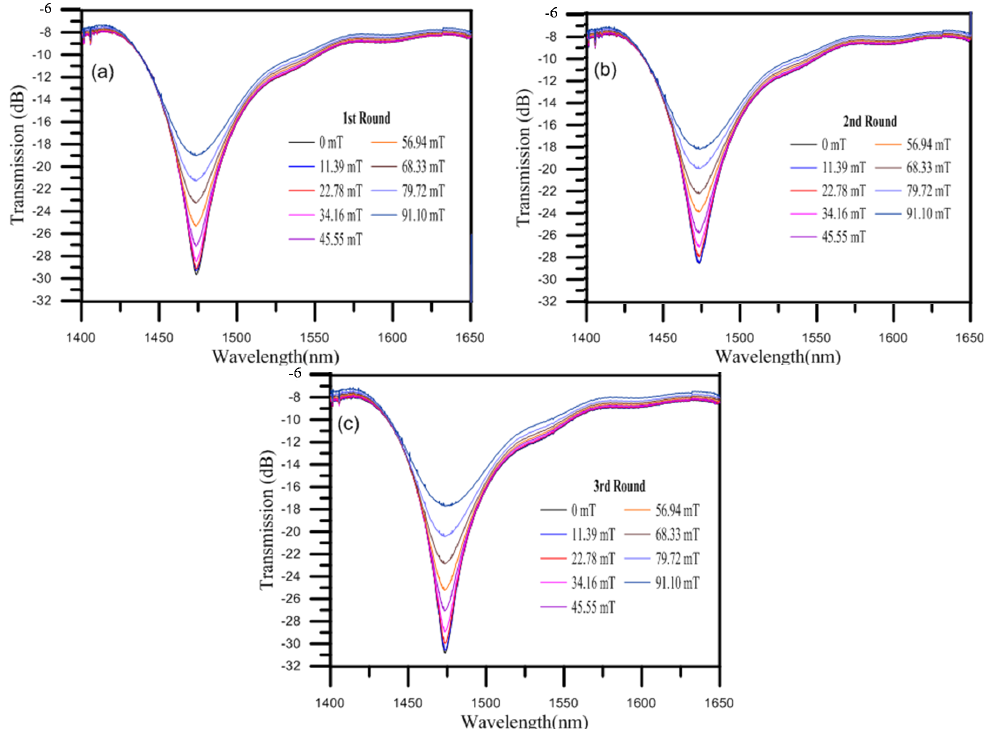
Figure 5. The spectra of the MRSLPFG magnetic sensor under distinct magnetic flux densities. ( a ) Spectra of first round for magnetic field sensing. ( b ) Spectra of second round for magnetic field sensing. ( c ) Spectra of third round for magnetic field sensing.